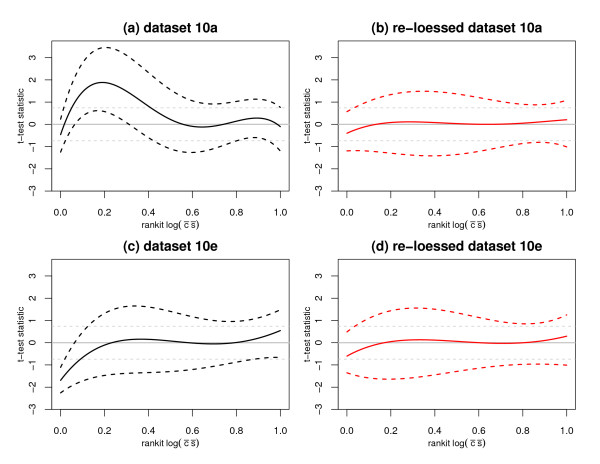
Estimates of the null t-test statistic quartiles vary as a function of signal intensity for datasets 10a (a, b) and 10e (c, d); although less so for the re-loessed data. The x-axes correspond to the rankit (i.e., rank of valuetotal#of values+1
 MathType@MTEF@5@5@+=feaafiart1ev1aaatCvAUfKttLearuWrP9MDH5MBPbIqV92AaeXatLxBI9gBaebbnrfifHhDYfgasaacH8akY=wiFfYdH8Gipec8Eeeu0xXdbba9frFj0=OqFfea0dXdd9vqai=hGuQ8kuc9pgc9s8qqaq=dirpe0xb9q8qiLsFr0=vr0=vr0dc8meaabaqaciaacaGaaeqabaqabeGadaaakeaadaWcaaqaaiabbkhaYjabbggaHjabb6gaUjabbUgaRjabbccaGiabb+gaVjabbAgaMjabbccaGiabbAha2jabbggaHjabbYgaSjabbwha1jabbwgaLbqaaiabbsha0jabb+gaVjabbsha0jabbggaHjabbYgaSjabcocaJiabb+gaVjabbAgaMjabbccaGiabbAha2jabbggaHjabbYgaSjabbwha1jabbwgaLjabbohaZjabgUcaRiabigdaXaaaaaa@52A7@) of the log of the product of the expression means. The y-axes correspond the observed two-sided t-test statistics. Solid and dashed grey lines indicate the theoretical medians and quartiles, respectively. The null t-test statistics were modeled as a function of a 4th order polynomial for rankit intensity. Black and red lines correspond to the quantile regression fits for τ = 0.5 (solid) and τ = 0.25, 0.75 (dashed). The overwhelming positive deviation of the null distribution in (a) is consistent with the discrepancy between the one-sided p-values observed in Figure 2(b). Portions of this figure appear with permission in the response to [2].